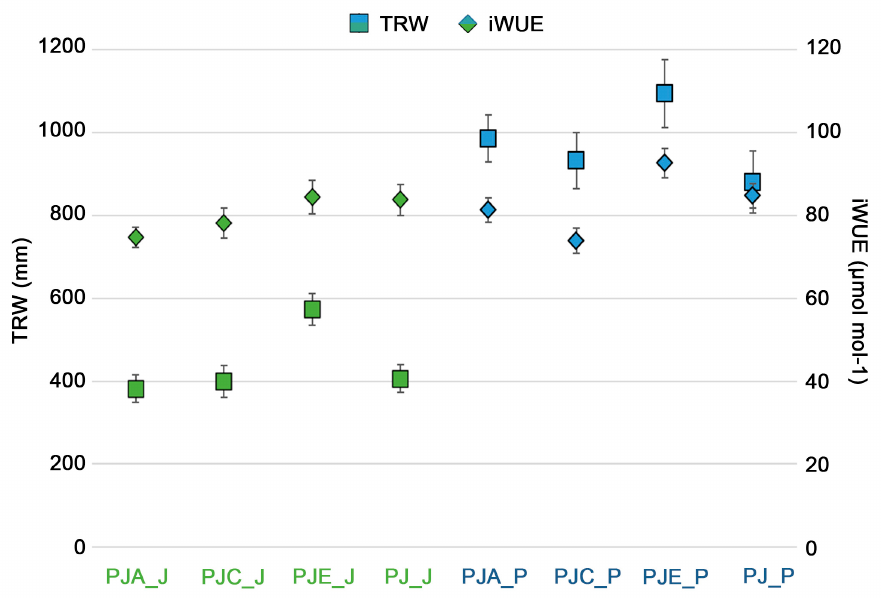
Figure 6. Comparison between the average values of TRW (square indicator) and the average values of i WUE (rhombus indicator) calculated for Juglans regia (in green) and Populus alba (in blue) in the different plots. The bars indicate the standard error. Differences between intercropping systems were evaluated according to one-way ANOVA, using Student–Newman–Keuls coefficient for com- parison tests ( p < 0.05).